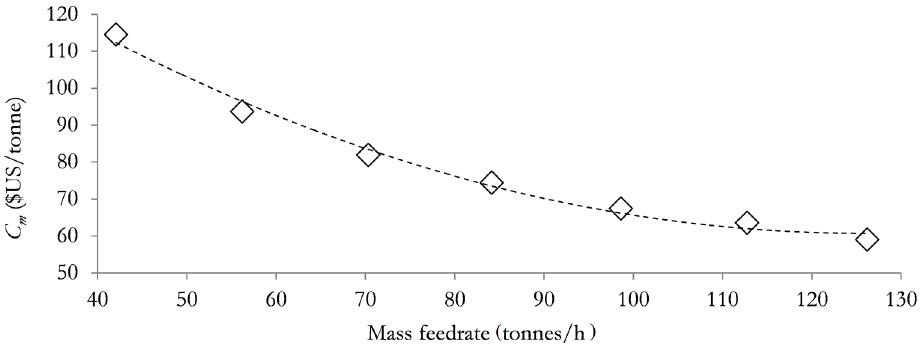
Figure 4. Dependence of C m on the mass feed rate of the meat processing waste streams.